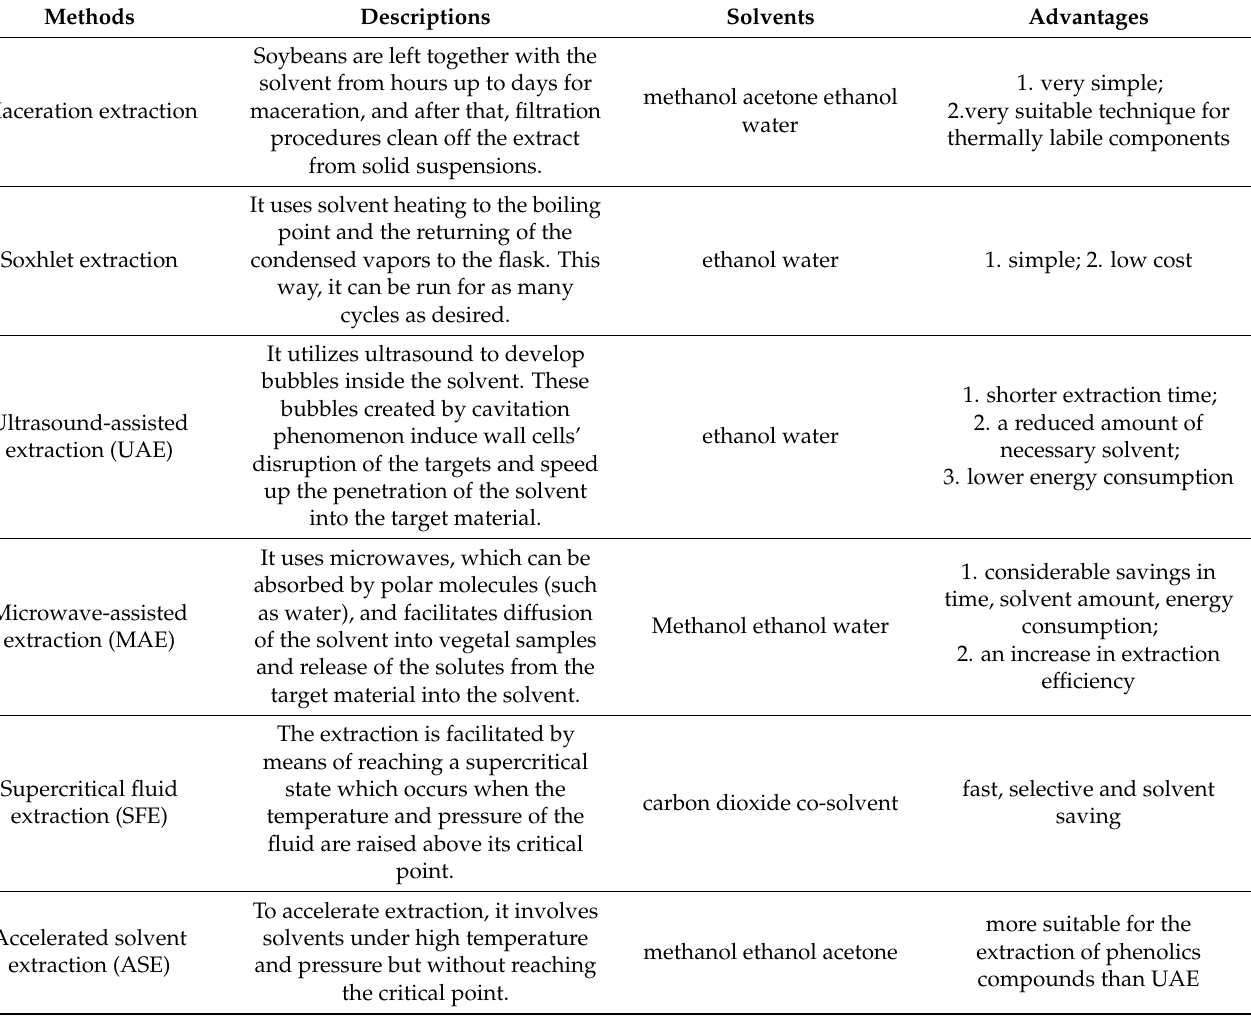
Table 1. A summary of extraction techniques used for bioactive components (isoflavones and other polyphenols).